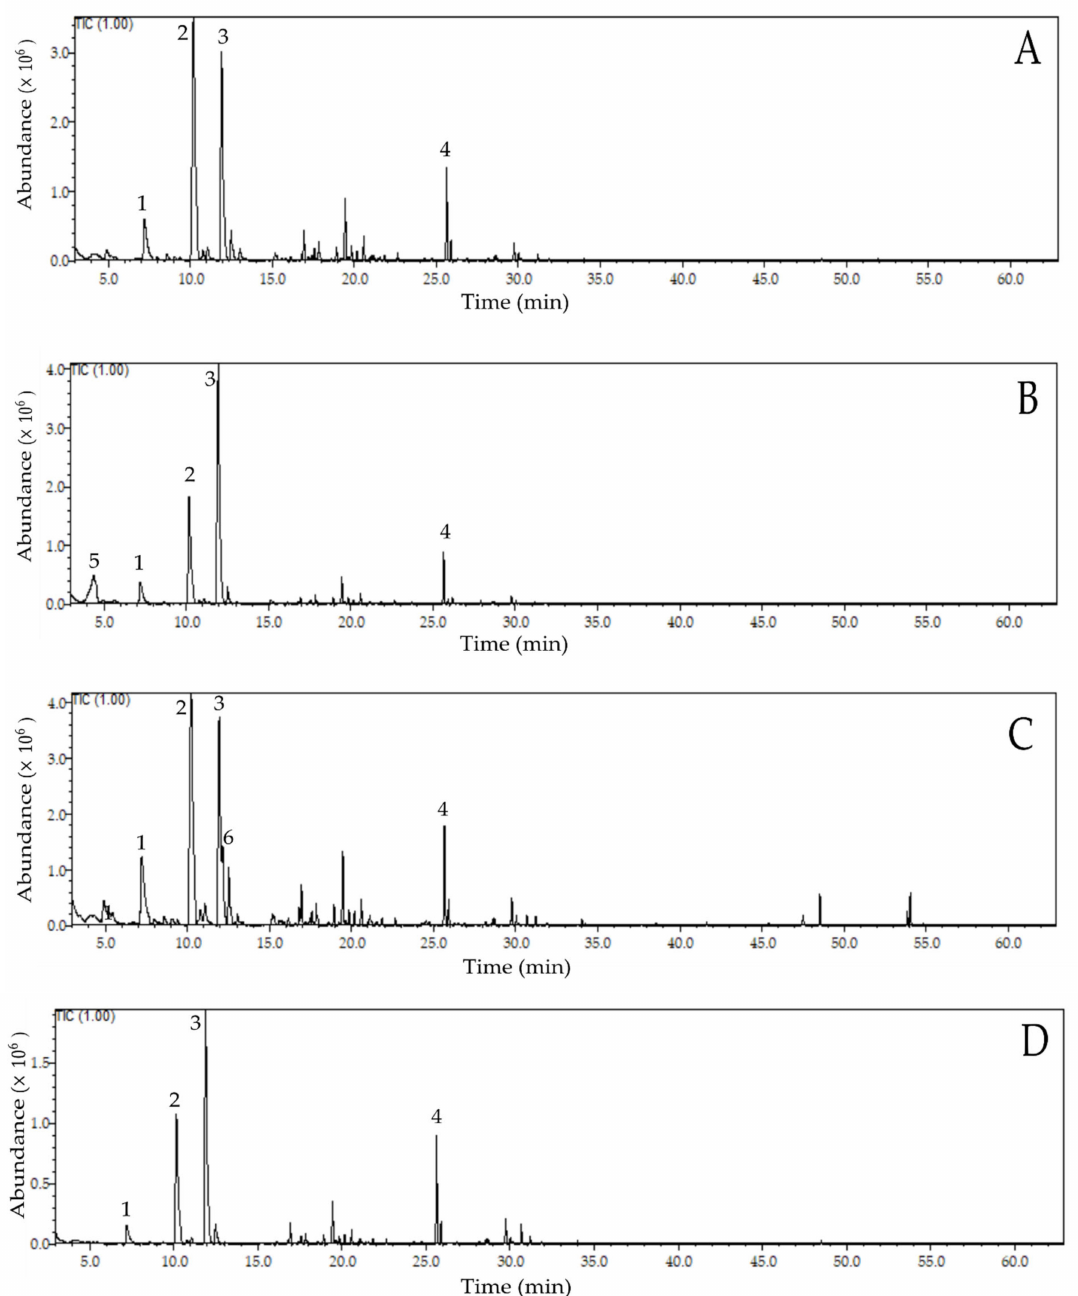
Figure 1. Ion Chromatograms of the GC-MS analysis on fermented and dried cocoa beans in four treatments 1 . Notes: 1 : CT— control treatment ( A ); ST—Saccharomyces cerevisiae inoculum ( B ); PT—Pichia kudriavzevii inoculum ( C ) and SPT—S. cerevisiae and P. kudriavzevii inoculum (1:1), ( D ). (1)—Benzaldehyde; (2)—Phenylacetaldehyde; (3)—Tetramethylpyrazine; (4)—Isoamyl benzoate; (5)—Isovaleric acid;